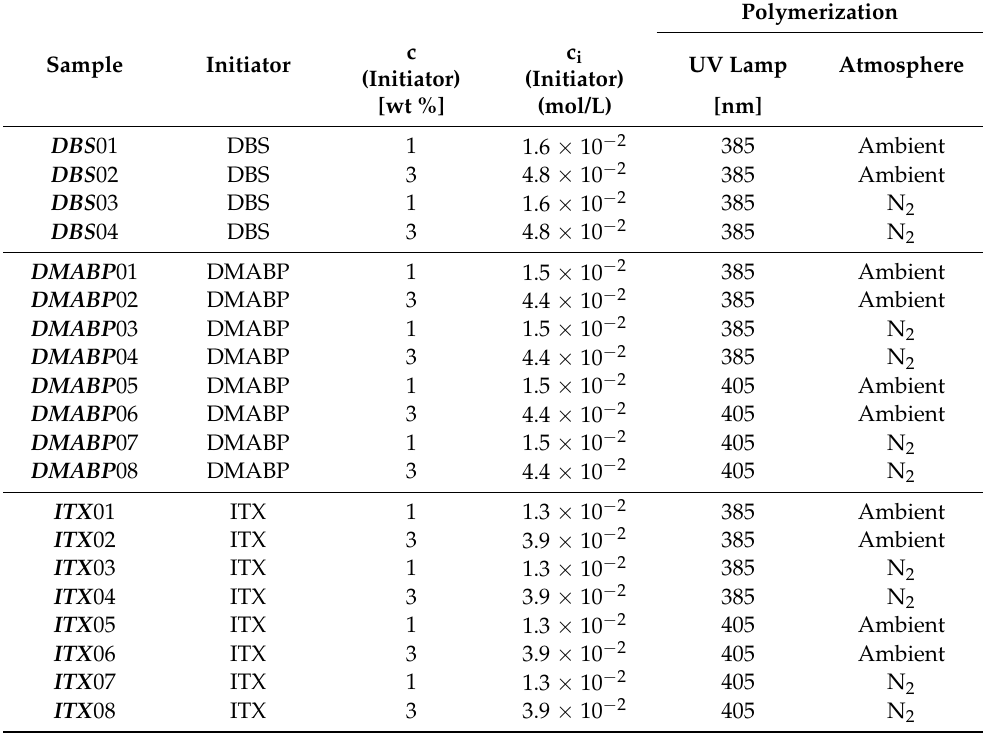
Table 1. Overview of the sample description with respect to the used UV lamp and atmosphere as parameters for the polymerization process. All mixtures contain 100 wt% Durazane 1800 and were cured for 300